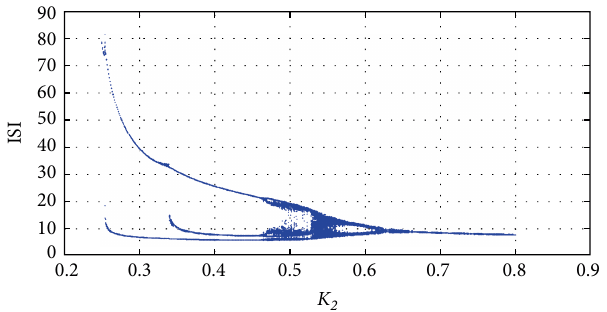
Figure 5: Bifurcation diagram of ISI by setting 𝑘 parameter with 𝐼 = 0 , 𝑘